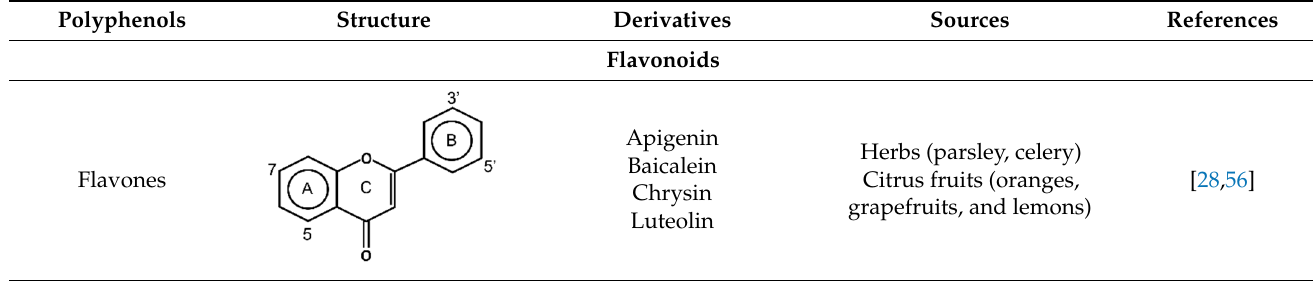
Table 2. Polyphenols and their derivatives in fruit.